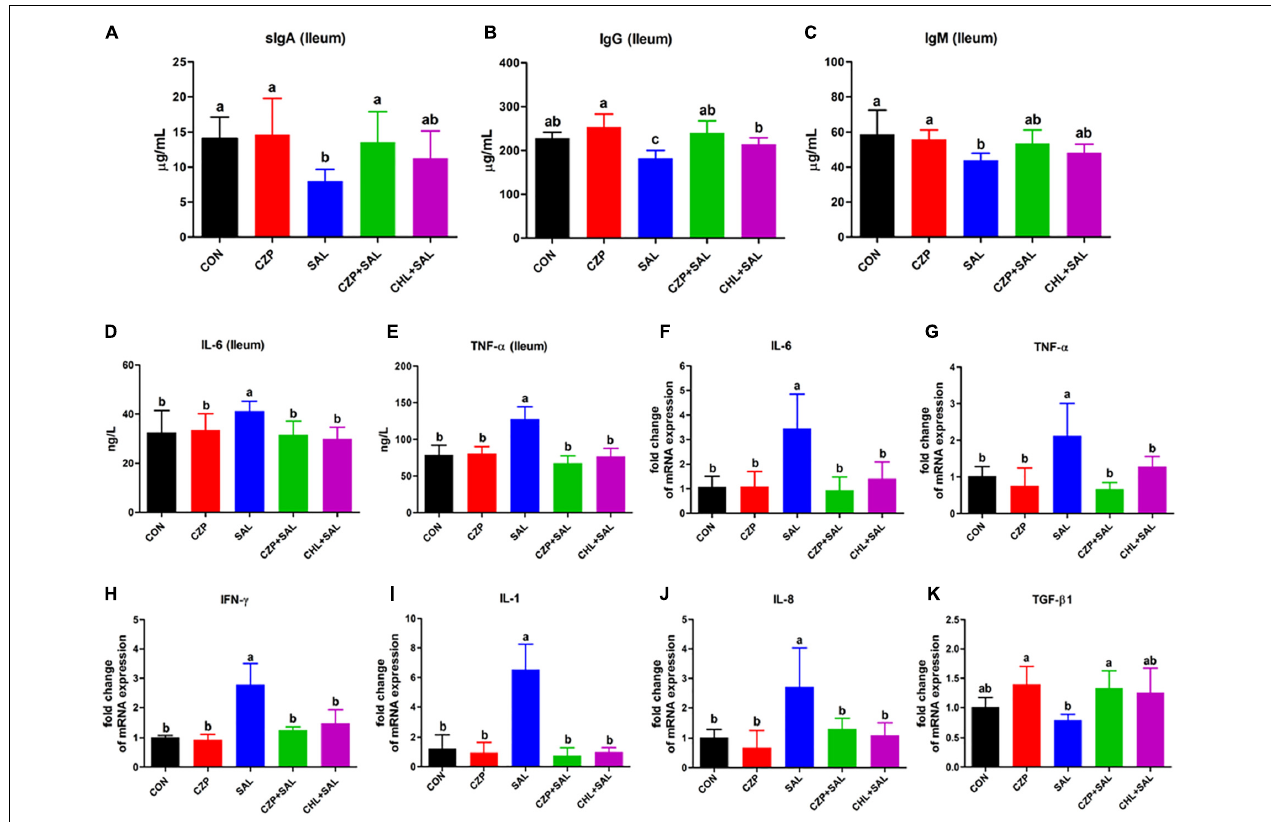
FIGURE 4 | Cu/Zn-Pal-1 modulates the expression levels of immune cytokines in the intestine. (A–C) The protein expression levels of sIgA, IgG, and IgM in the ileum were detected using ELISA kits ( n = 6/group). (D,E) The protein expression levels of IL-6 and TNF- α in the ileum were determined by ELISA kits ( n = 6/group). (F–K) The mRNA expression levels of cytokines (IL-6, TNF- α , IFN- γ , IL-1, IL-8, and TGF- β 1) in the ileum were detected by real-time PCR ( n = 9/group). Data are expressed as the mean ± SD. Significant difference were identified using one-way ANOVA statistical analysis ( p < 0.05). Different letters indicate that the changes between groups are statistically